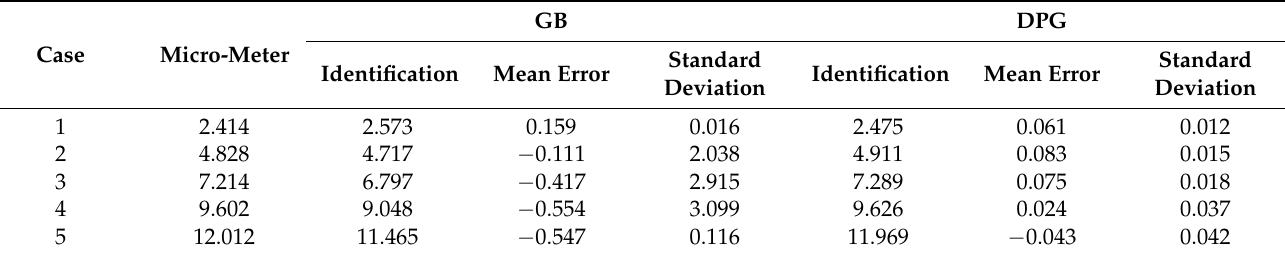
Table 5. Deflection identification at the micrometer 2 (units: mm).